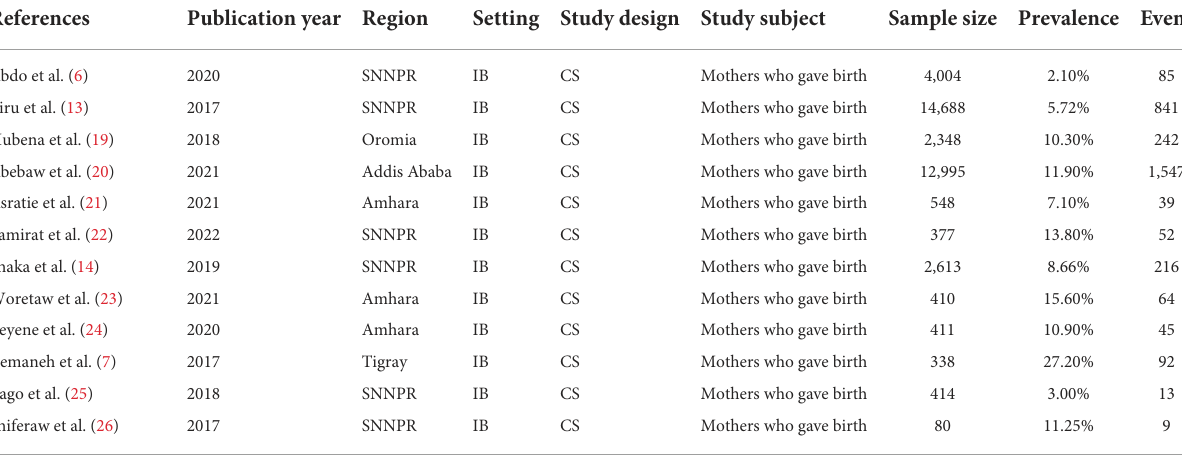
TABLE 1 General characteristics of studies included in the systematic reviews and meta-analysis among mother who gave birth in Ethiopia, 2022.